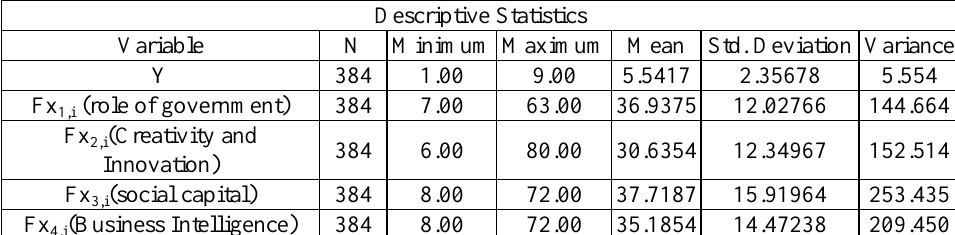
Table. 2. Descriptive Test of Research Variables